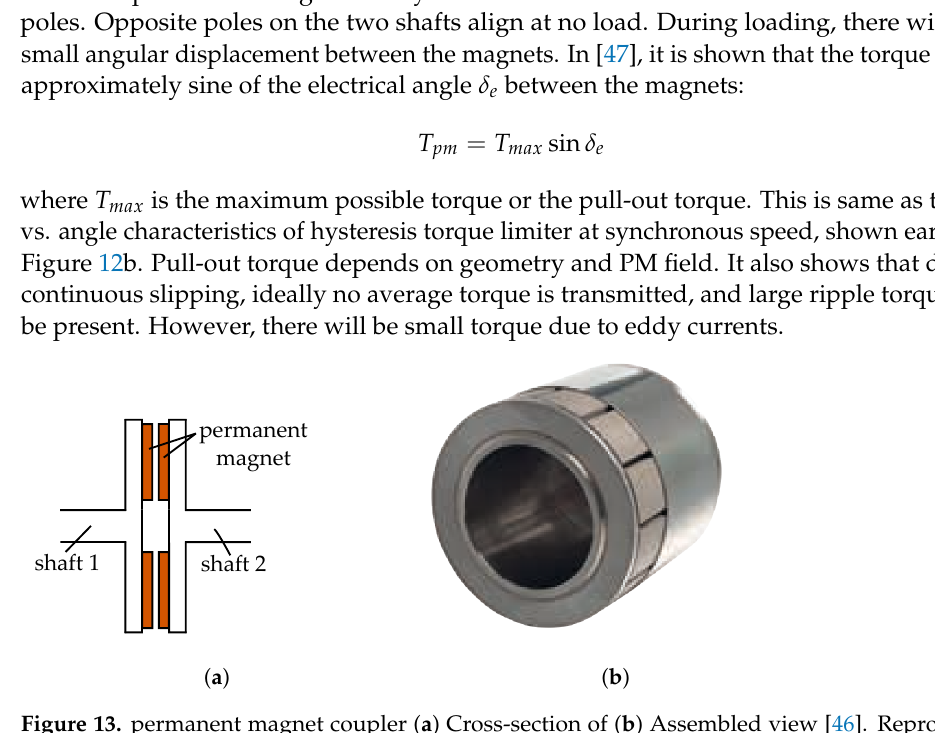
Figure 13. permanent magnet coupler ( a ) Cross-section of ( b ) Assembled view [46]. Reproduced with permission from